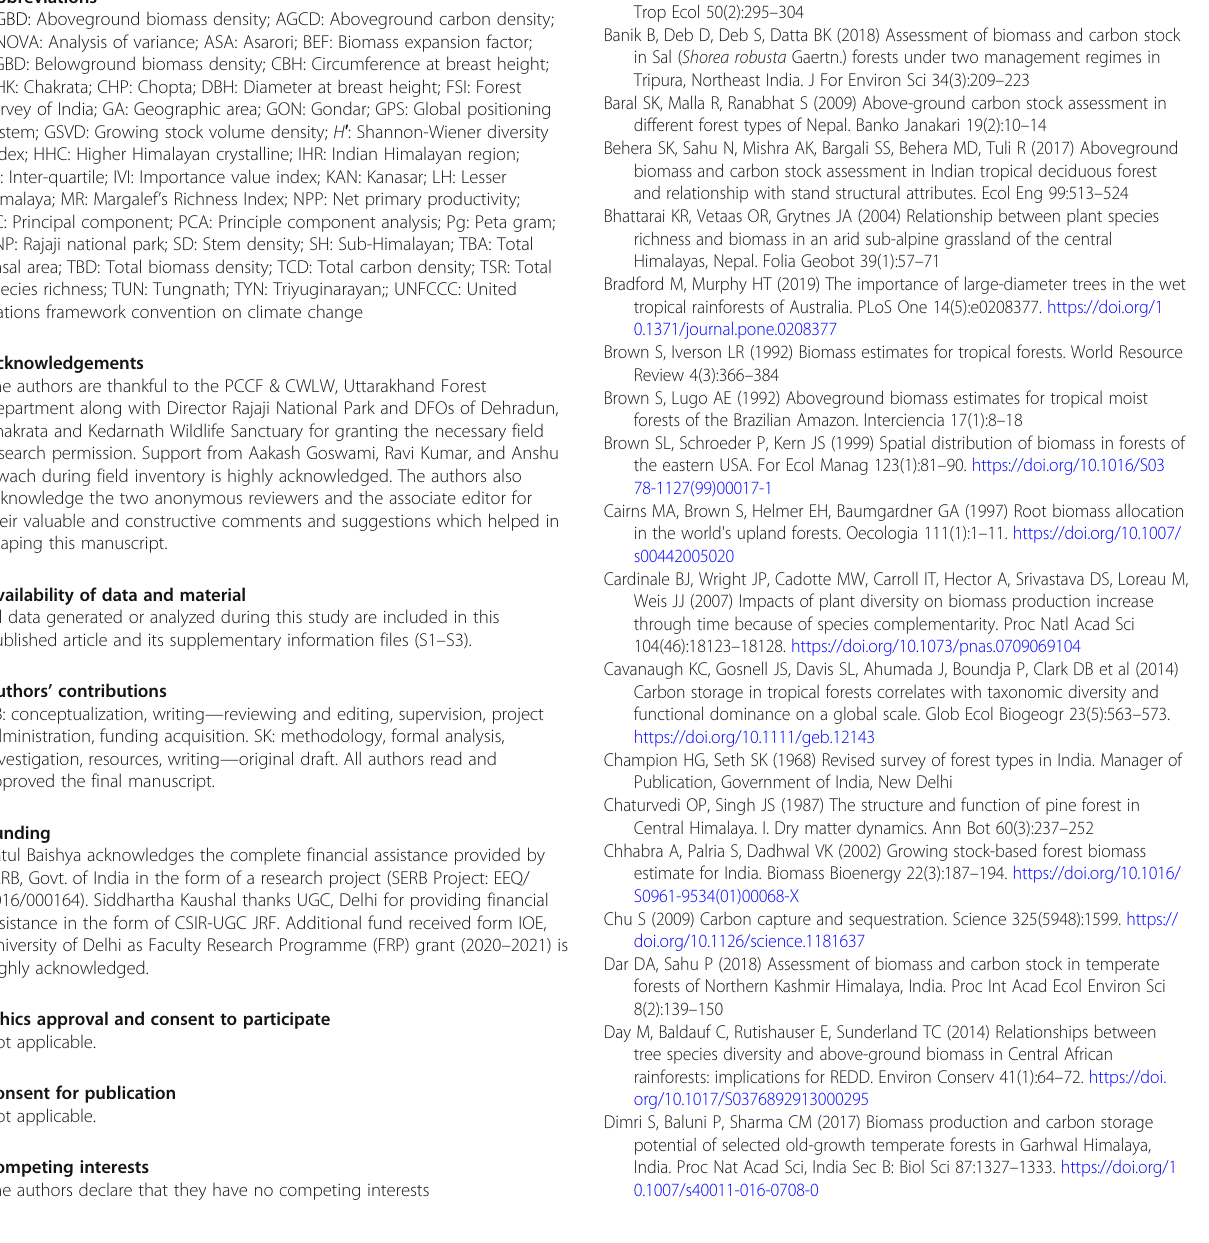
Supplementary Table S2. Percentage distribution of stem density and total carbon density of different species in studied forest types. Supplementary Table S3. Total carbon density of all the 53 tree species arranged in order of decreasing TCD. Values in parenthesis indicate relative